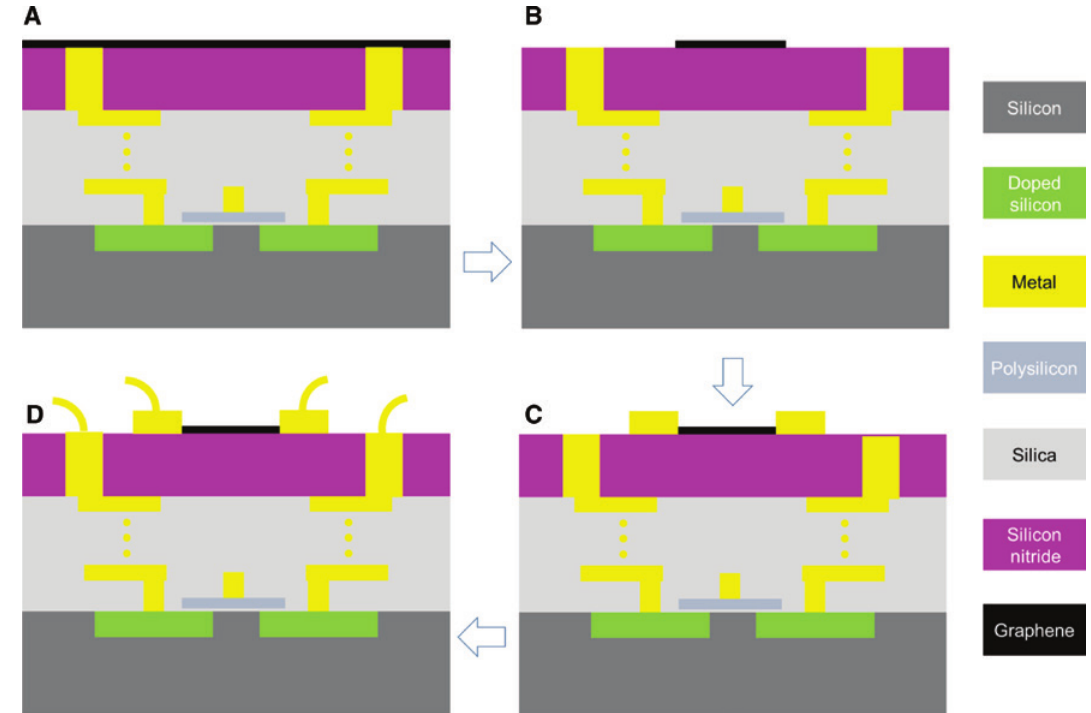
Figure 2: Schematic of main fabrication steps of the optical receiver. (A) CVD graphene is transferred on the surface of the IC chips. (B) A patterned graphene channel is obtained. (C) Metal contacts of graphene are completed. (D) A wire bonding process is completed for